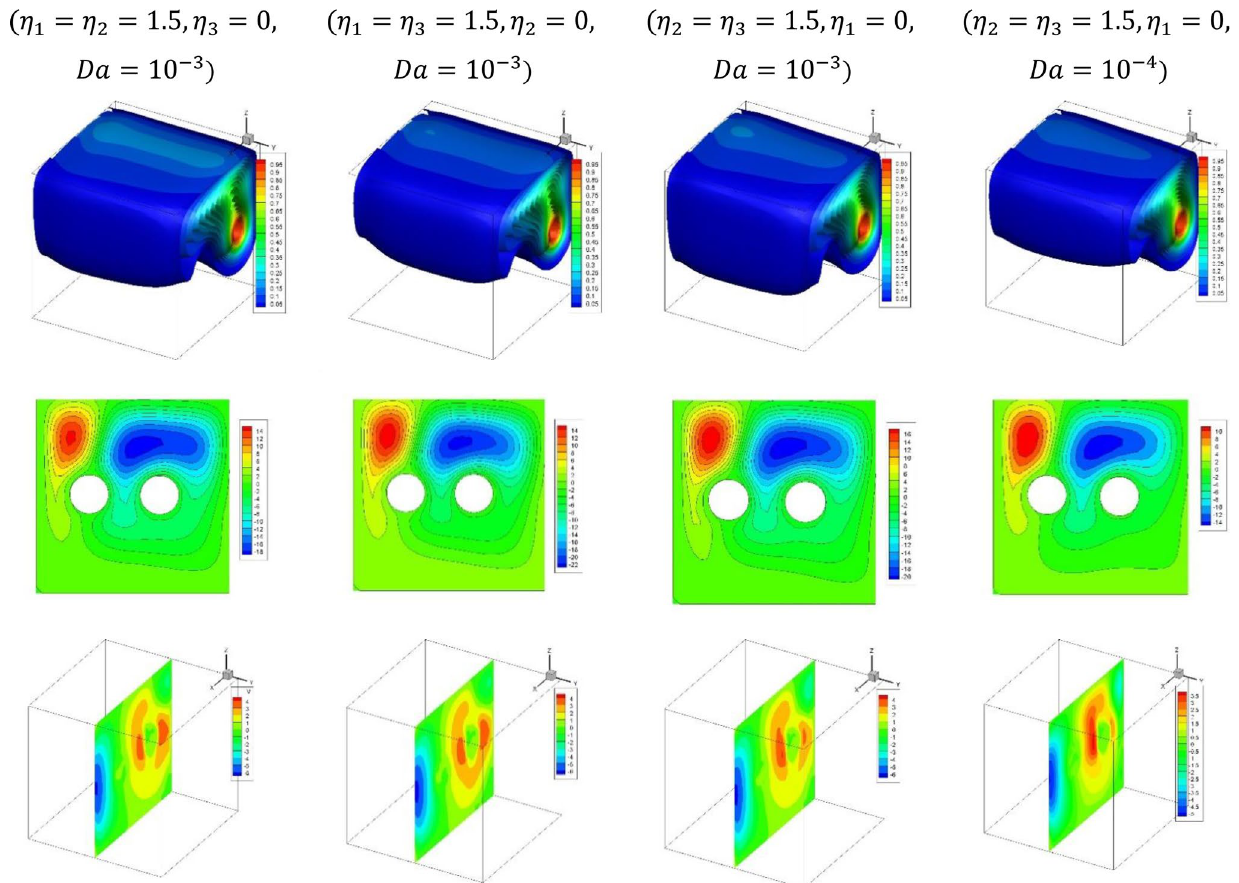
Figure 4. Plots of the temperature distributions, streamlines and dusty velocity W p for the variations of ( (η 1 , η 2 , η 3 and Da ) at δ